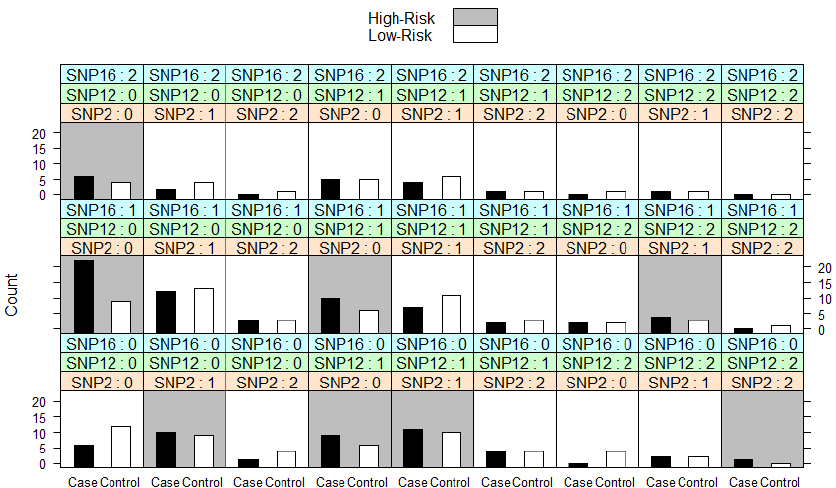
Figure 1. The illustration of MDR fit with three-way split on LVAD dataset with 98 indi- viduals at 21 SNPs (k = 3). SNP 2 is polymorphism rs9934438 in VKORC1*2 gene; SNP12 is polymorphism rs2070959 in UGT1A6 gene; SNP16 is polymorphism rs1801133 in MTHFR*1 .